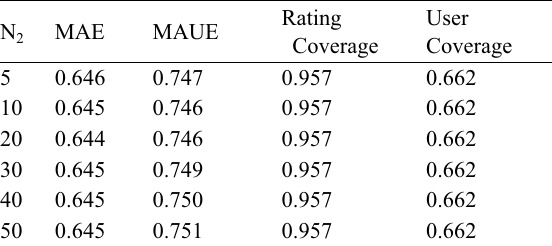
N on Flixster. 2